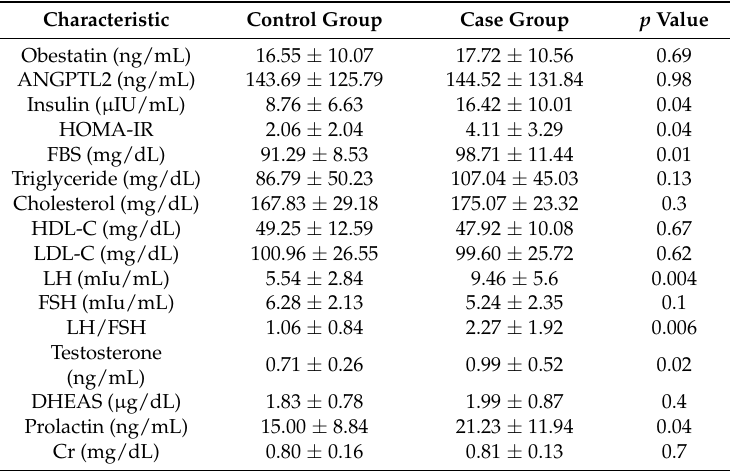
Table 2. Serum concentrations of variables in case and control groups.